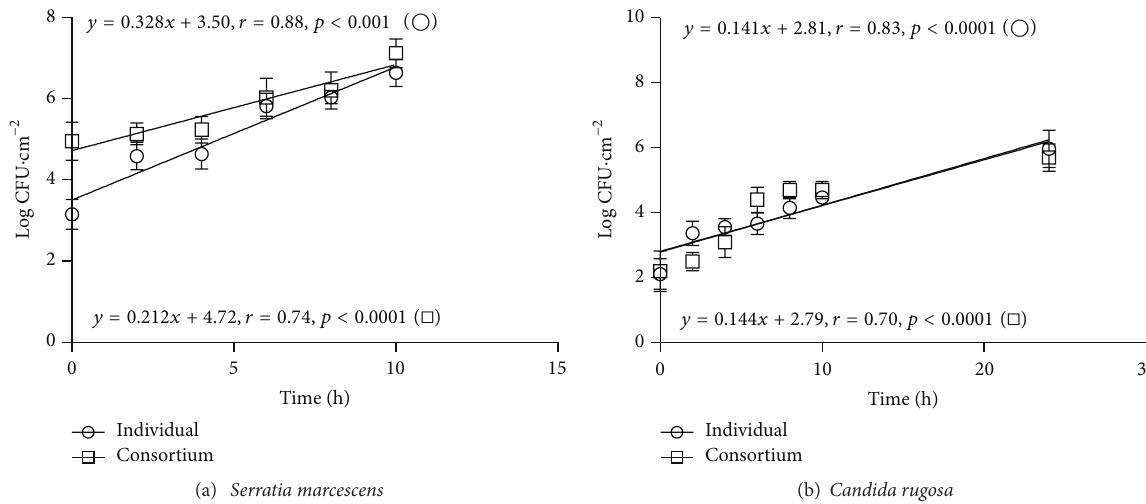
Figure 1: Growth curves of Serratia marcescens (a) and Candida rugosa (b) as individual cultures ( I ) and in a microbial consortium ( ◻ ) on polyurethane foam coupons immersed in the Luria-Bertani (LB) broth for 24